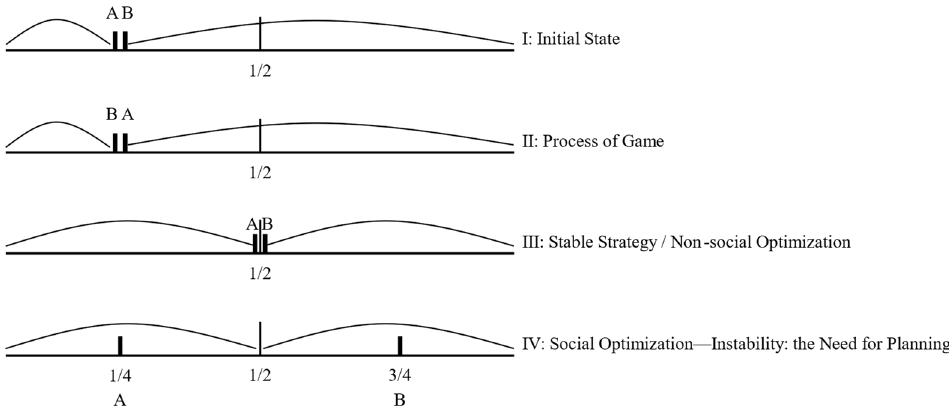
Figure 4. Social optimization model: A and B are two ice cream stands on the coastline that offer exactly the same goods and services.